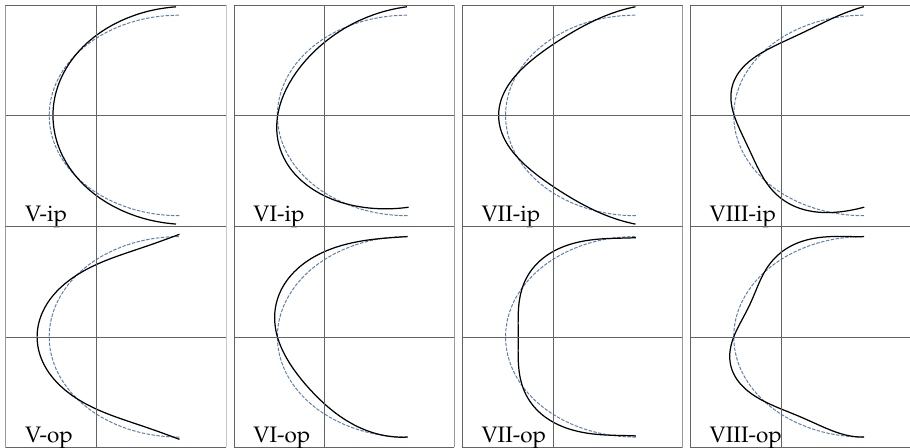
Figure 4. In-plane (ip) and out-of-plane (op) components of the trial functions, from I to IV (rigid modes). Blue dashed line: initial configuration; black solid line: trial functions.